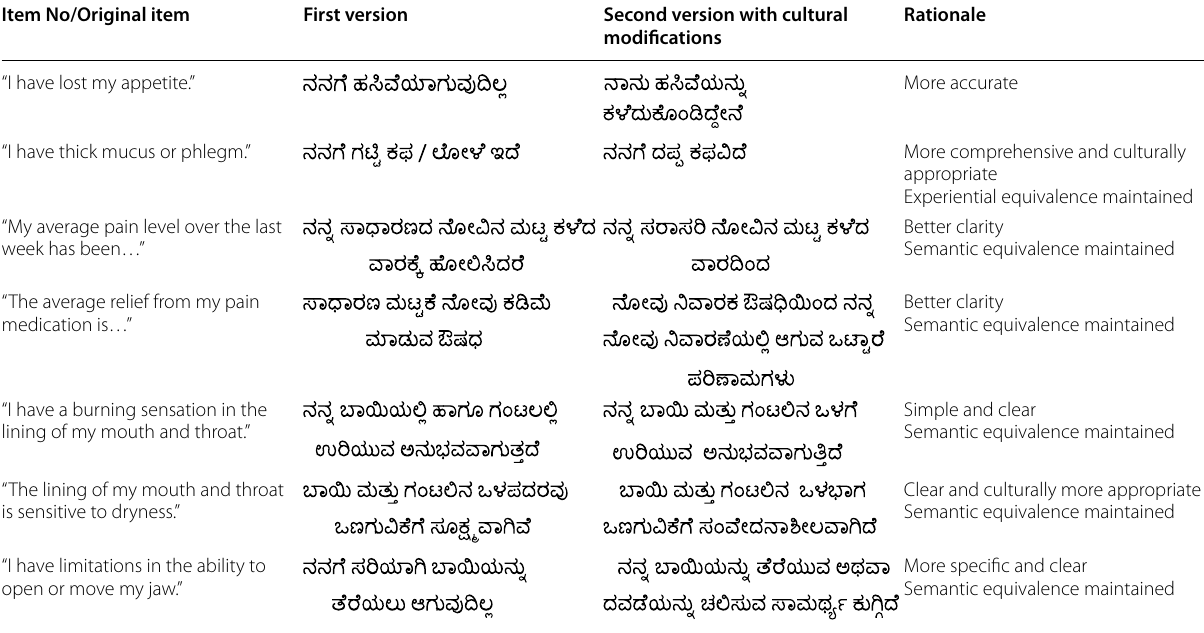
Table 1 Modifications suggested by the experts and translators for the culturally adapted VHNSS